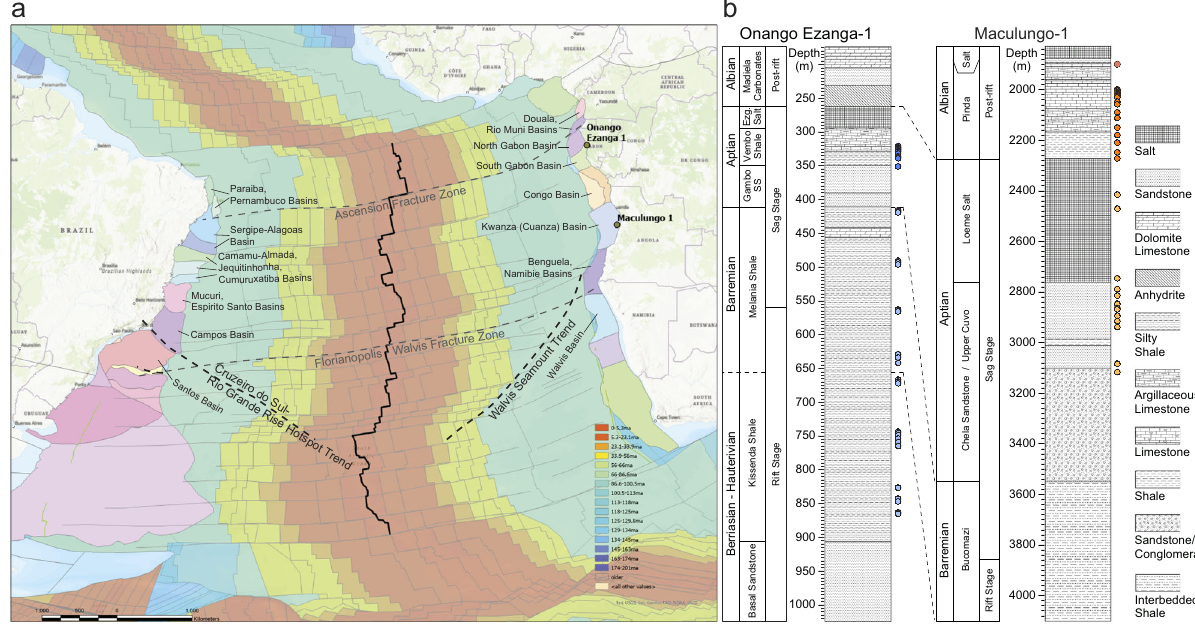
Fig. 1 Geographic locations and stratigraphy of two drill cores, Onango Ezanga-1 (ONEZ-1) and Maculungo-1 (MA-1). a Core locations where positional rift basins on both African and Brazilian margins are depicted in different colors. Major tectonic features (e.g., fracture zone) are annotated with gray and black dashed lines. The basemap was generated in ArcPro TM by adopting the plate reconstruction from the EarthByte 2019 plate model 73 . b Generalised stratigraphy with tectonic stages and drill core depths showing the placement of rock samples selected for this study. The stratigraphy and age models of both drill cores were revised from previous publications 52,53 , by incorporating logging data with recent constructions of rift basin stratigraphy and age constraints 7,54,57,58 . Samples were selected randomly to avoid any lithologic bias. Drill core depths are presented in meters (m) below surface. Dark blue and light blue represent the Aptian and Berriasian-Barremian samples of the ONEZ-1 core, whereas dark orange and light orange indicate Albian and Aptian samples of the MA-1 core,